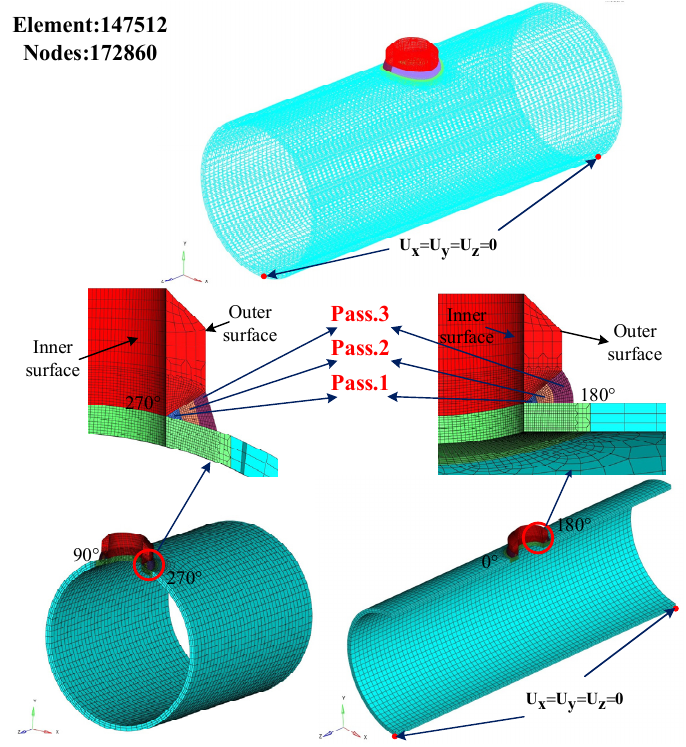
Figure 4. Three-dimensional (3D) finite element mesh with boundary conditions.